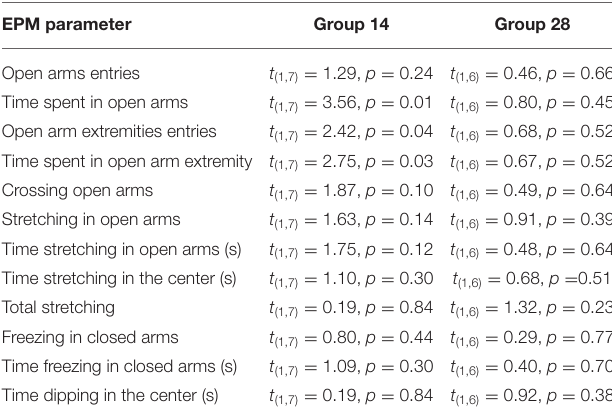
TABLE 1 | Body weight measures (g). TABLE 2 | Parameters measured in the Elevated Plus Maze (EPM)